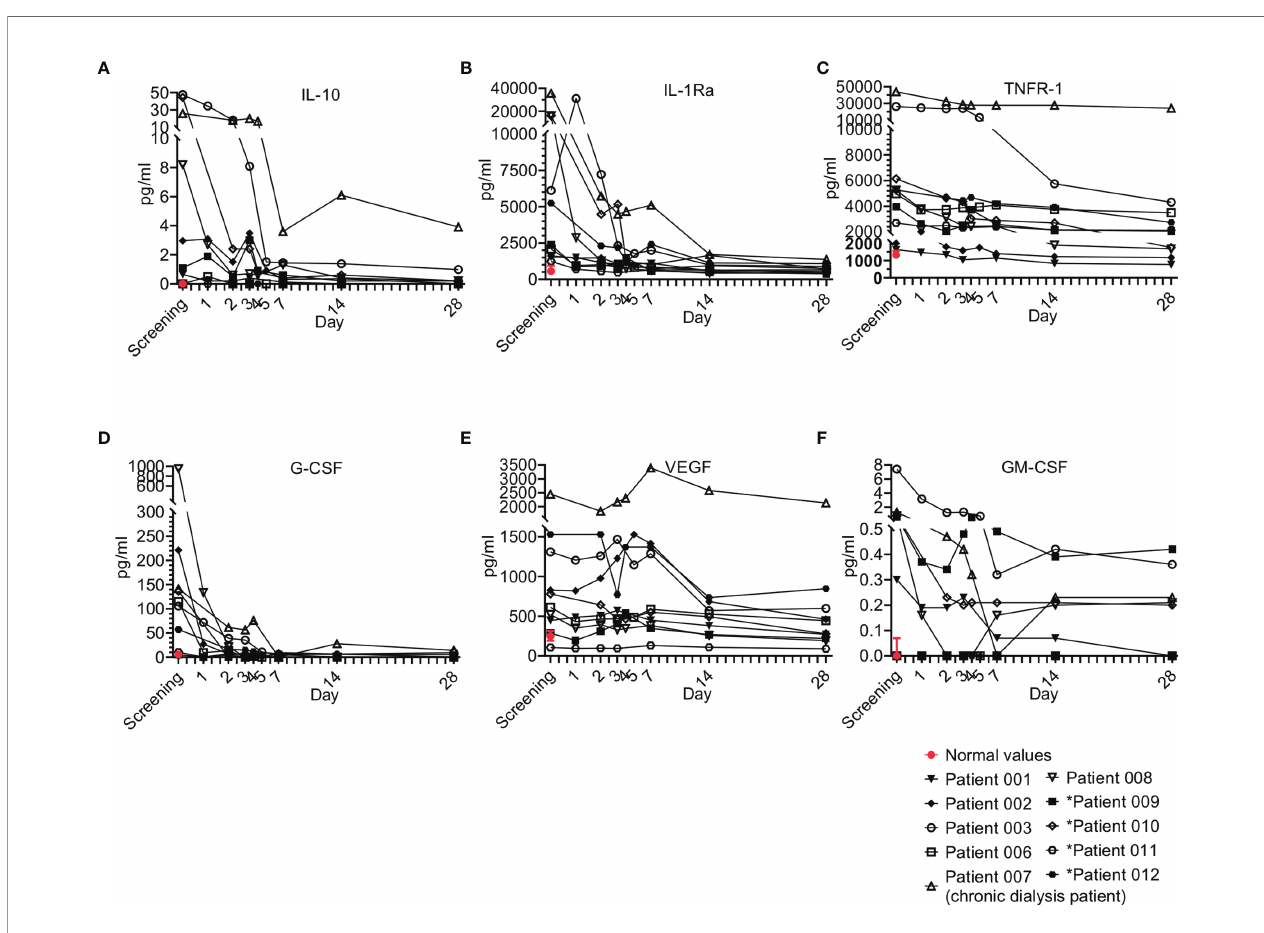
FIGURE 6 | Anti-In fl ammatory cytokine and growth factor kinetics during sepsis. Serum was obtained from patients at the indicated times and cytokine/growth factor analysis was performed as described in Methods. The serum of three healthy volunteers was analyzed using the same methods and values are presented as the normal range (median ± range). Serum concentrations of (A) IL-10, (B) IL-1Ra, (C) TNFR-1 are presented in the upper panel, (D) G-CSF, (E) VEGF, and (F) GM- CSF are presented in the lower panel. Patients 01 – 08 received one dose of Allocetra-OTS on day 1 and patients 09 – 12 received two doses on days 1 and